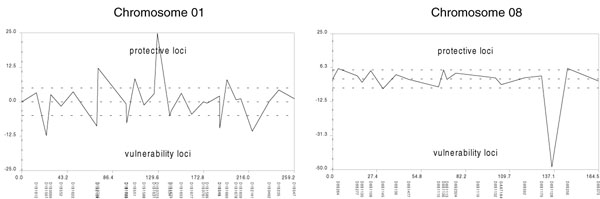
Vulnerability-related (negative signs) and protective loci (positive signs) on chromosomes 1 and 8 as derived by the multivariate sib-pair method The contribution of each locus to the oligogenic model of ethnicity-independent vulnerability is plotted along the y-axis (%), while the genomic regions are plotted along the x-axis (cM).